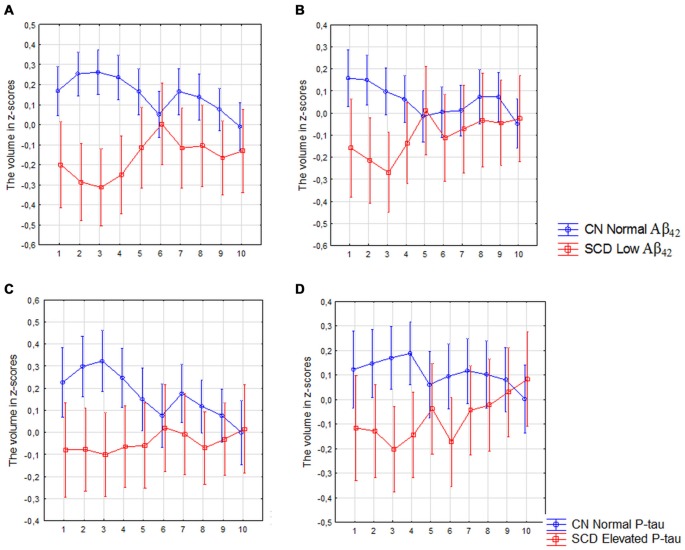
SCD with low Aβ42 or elevated P-tau CSF levels compared with controls with normal Aβ42 or P-tau levels. The figure denotes differences in subicular volume segment in SCD with abnormal (red line) and CN with normal (blue line) CSF biomarkers. (A,B) Display the volume segment in left (A) and right (B) subiculum in CN without and SCD participants with low CSF Aβ42. (C,D) Display the volume segment in left (C) and right (D) subiculum in CN without and SCD participants with elevated CSF P-tau. The x-axis denotes volume segment from posterior (segment 1) to anterior (segment 10). The y-axis denotes the volume of segment normalized as z-scores. The analysis is controlled for gender, intracranial volume and age. Vertical bars denote 95% confidence interval.